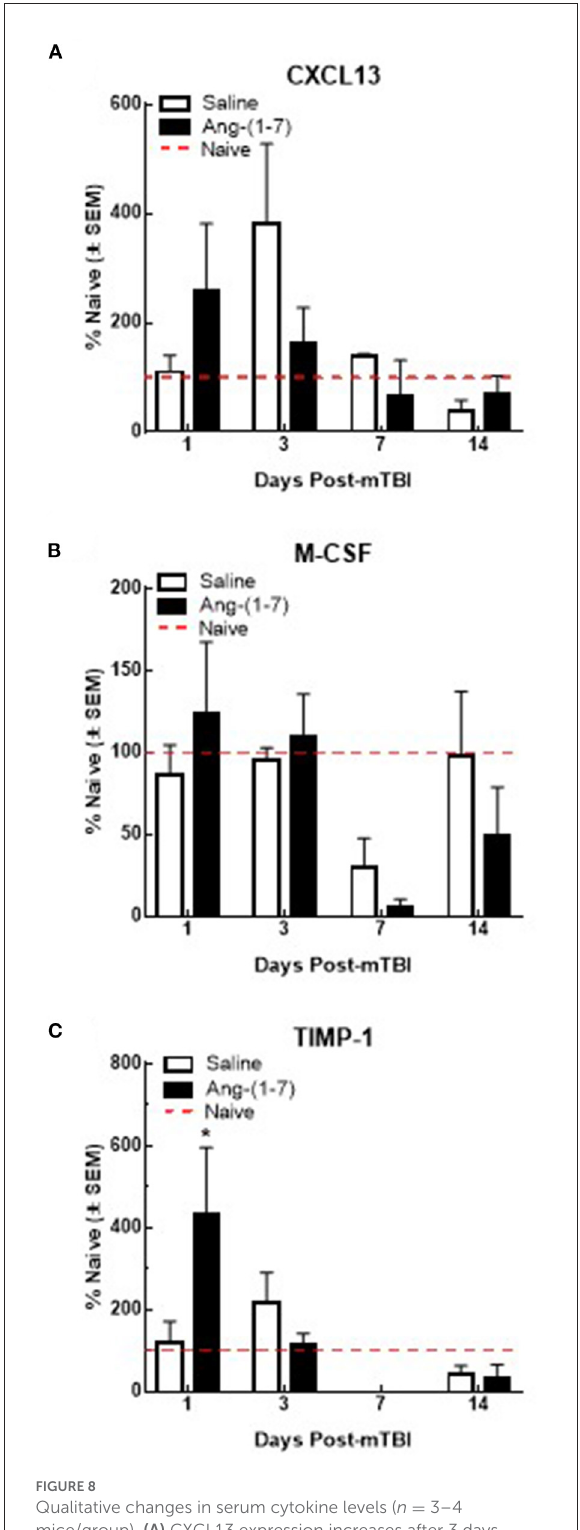
FIGURE8 Qualitative changes in serum cytokine levels ( n = 3–4 mice/group). (A) CXCL13 expression increases after 3 days post-mTBI in saline treated animals. Ang-(1-7) (1 mg/kg, i.p.) significantly normalized this mTBI induced CXCL13 increase